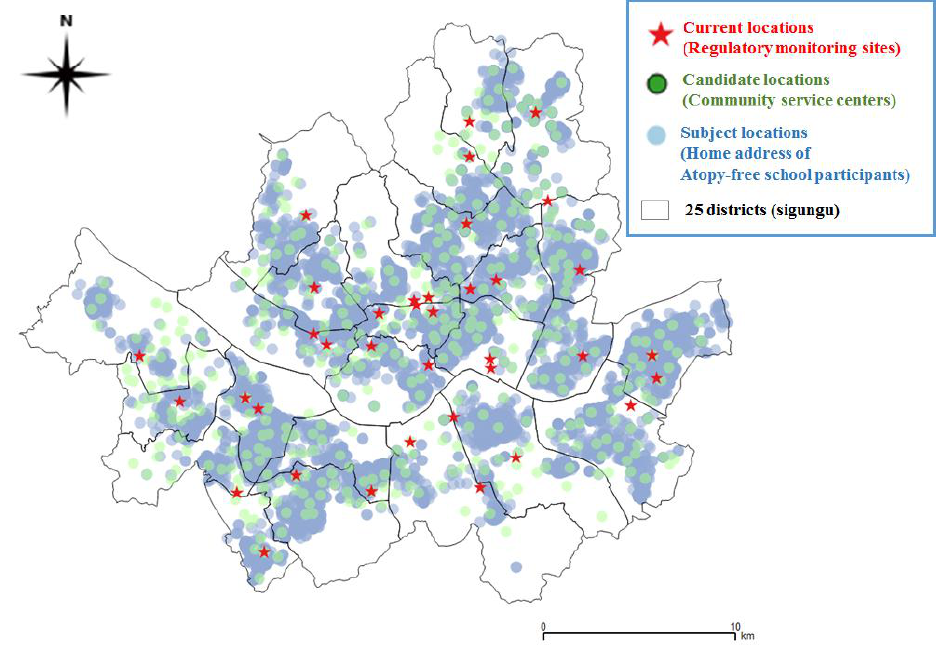
Figure 2. Map of 37 current locations (regulatory monitoring sites), 412 candidate locations (community service centers), and 31,097 subject locations (home addresses of the Atopy Free School survey children) in Seoul, Korea.